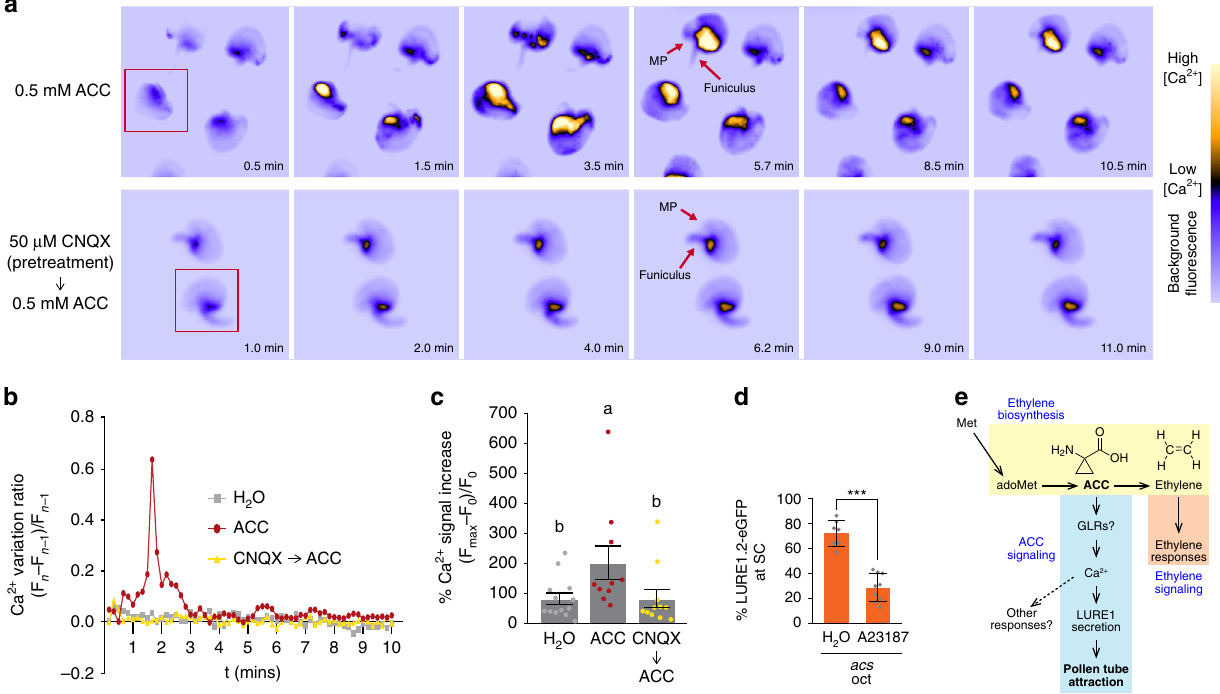
Fig. 4 ACC stimulates CNQX-dependent Ca 2 + elevation in ovules. a Representative time sequence after applying ACC (500 μ M) to ovules expressing cytosolic GCaMP3. Scale re fl ects arbitrary units of fl uorescence (see “ Methods ” ). Top row: time sequence of transient cytosolic Ca 2 + elevation after adding ACC. The Ca 2 + signal fi rst appears near the funiculus (seen from background fl uorescence) and expands to the rest of the ovule. Bottom row: similar time sequence after adding ACC (500 μ M) immediately after preincubation (10 min) with CNQX (50 μ M). (See Supplementary Movies 1, 2 for unprocessed movies.) Red boxes indicate the ovules whose signals are plotted in b . b Ca 2 + variation ratios for the time sequences of ovules in a (red boxes) and for ddH 2 O as a control. Treatments consist of ddH 2 O (gray square), ACC (red circle), and CNQX to ACC (yellow triangle). c Percentage of Ca 2 + signal increase for ovules treated with 500 μ M ACC ( n = 10), 500 μ M ACC (pretreated with 50 μ M CNQX; n = 11) and ddH 2 O ( n = 13). These data were analyzed with Kruskal – Wallis with Dunn ’ s post hoc test, df = 2, Kruskal – Wallis statistic = 9.062, Error bars show± s.e. d Treatment with the calcium ionophore A23187 rescues LURE1.2-eGFP localization in acs oct ovules. Average percentage of SC-localized LURE1.2-eGFP in acs oct ovules per pistil (for ovules whose localization could be determined). n = 7 and n = 9 for acs oct pretreated with ddH 2 O and 10 μ M A23187, respectively (two-tailed t -test, P < 0.0001 (****), t = 7.926, df = 14). Error bars show ± s.d. e Model of ACC signaling. Besides being the ethylene precursor, ACC induces Ca 2 +